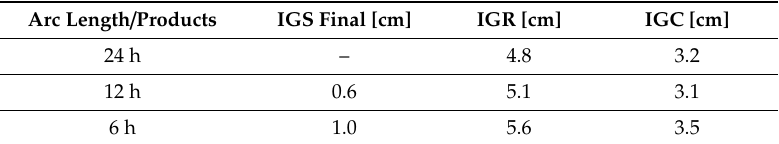
Table 5. 3D RMSE of the phase-based reduced-dynamic orbits with di ff erent arc lengths and using di ff erent IGS products. 10 s observation data with a duty-cycle of 100% and a mean satellite number of 9 were used for the processing.